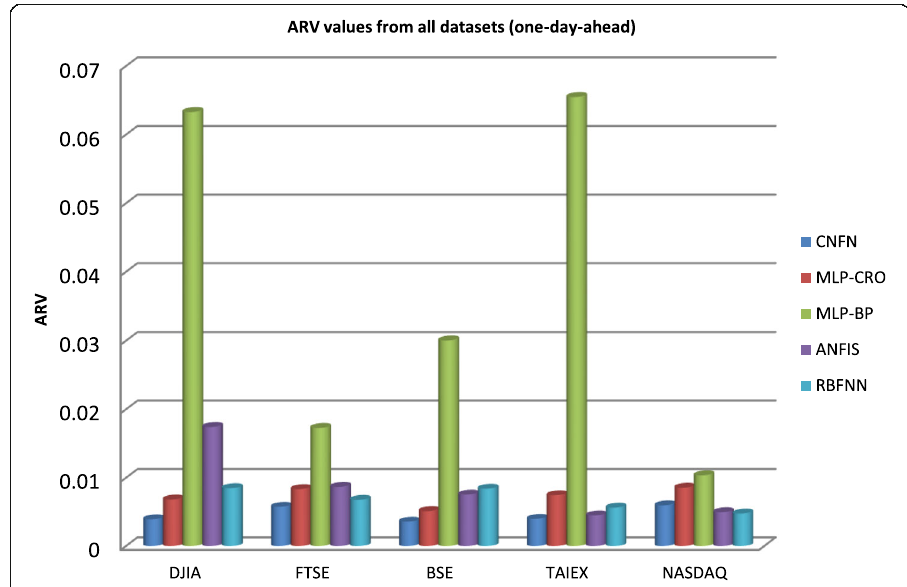
Fig. 11 ARV generated by all models from all datasets